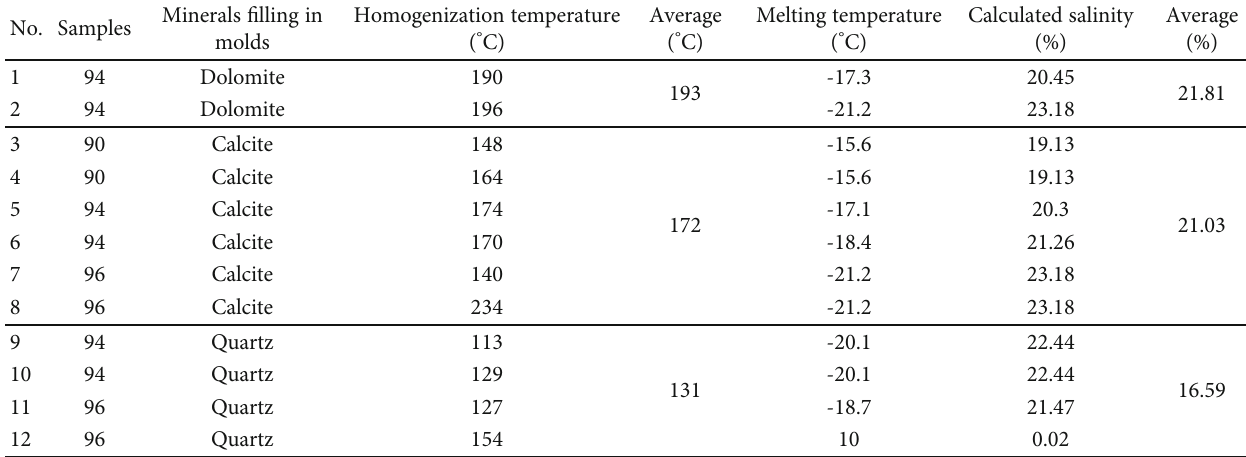
Table 2: Formation water composition of some wells of the Ordovician Majiagou Formation in the southeastern Ordos Basin. Well